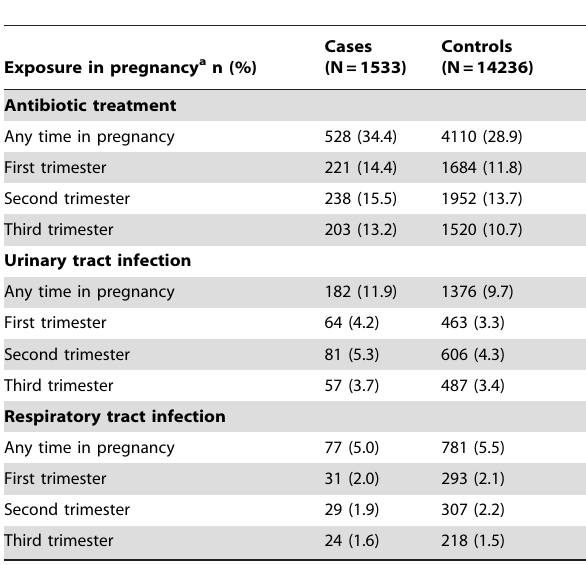
Table 2. Frequency of maternal infection or antibiotic treatment in pregnancy and by pregnancy trimester.